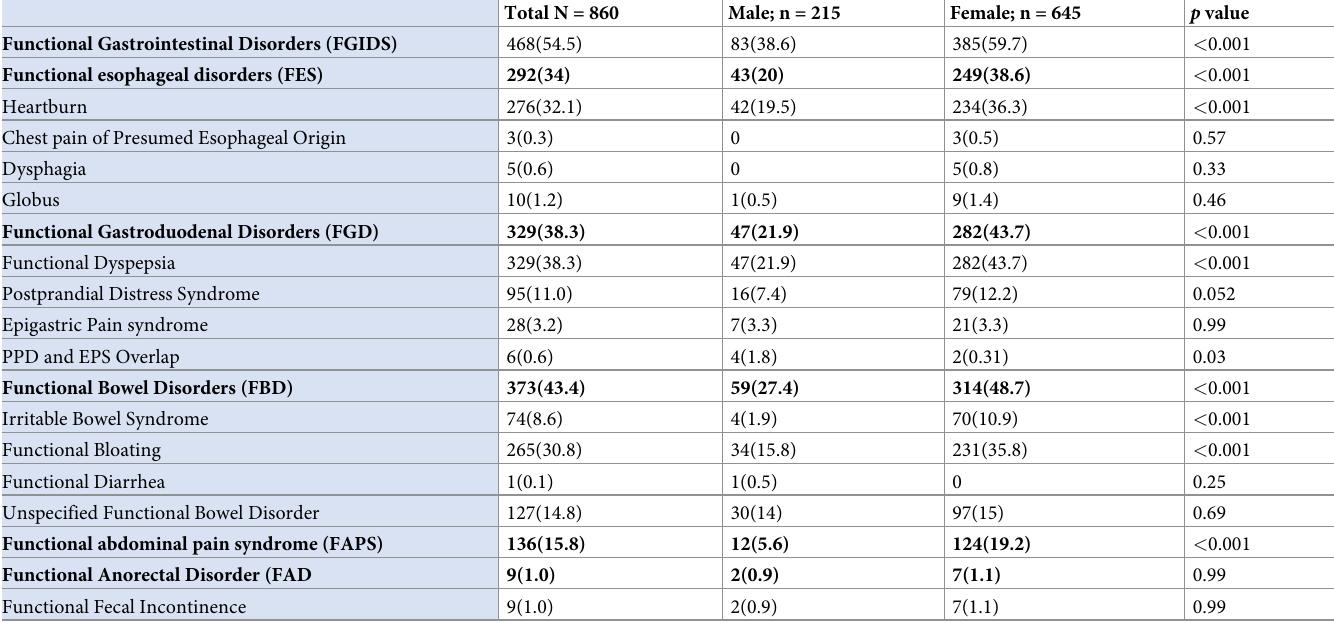
Table 2. Functional Gastrointestinal disorders (n =